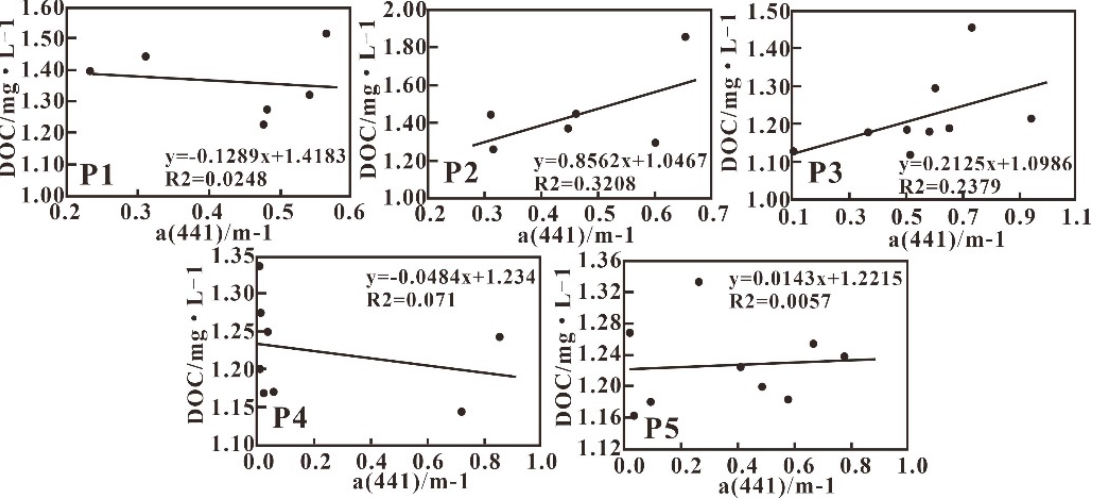
Figure 15. Relationship between DOC and α (441).